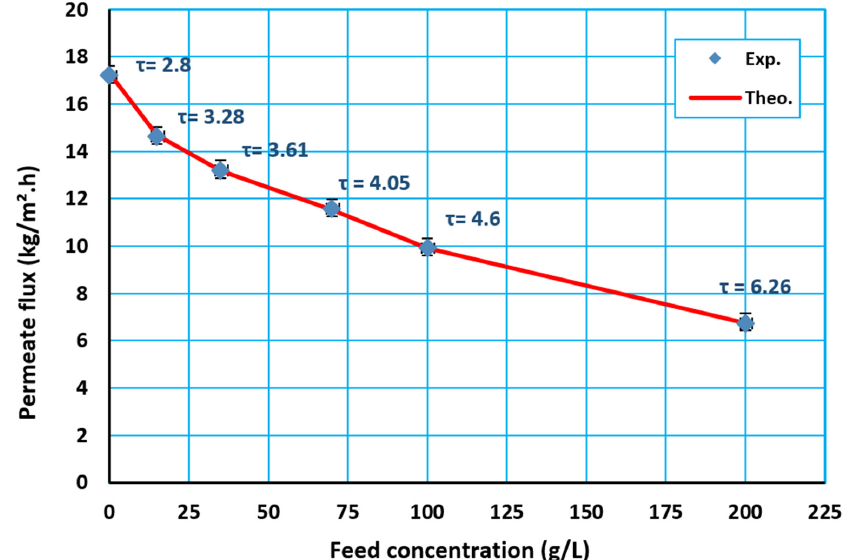
Figure 13. Effect of the feed concentration on the permeate flux at a feed concentration of 60 °C and a feed flow rate of 1.07 L/min.